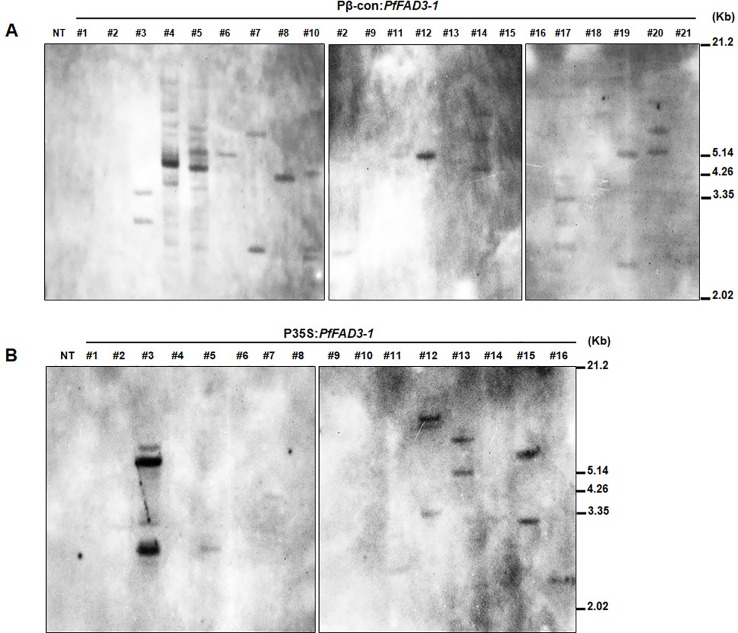
Genomic Southern blot analysis of PfFAD3-1 transgenic soybean (T0). Ten micrograms of genomic DNA from Pβ-con:PfFAD3-1
(A) and P35S:PfFAD3-1
(B) transgenic plants (T0) were digested with HindIII and hybridized with the Bar probe. Approximate DNA size markers are indicated on the right. NT, non-transgenic plant; #1–#21 (part A), Pβ-con:PfFAD3-1 transgenic lines (T0); #1–#16 (part B), P35S:PfFAD3-1 transgenic lines (T0).